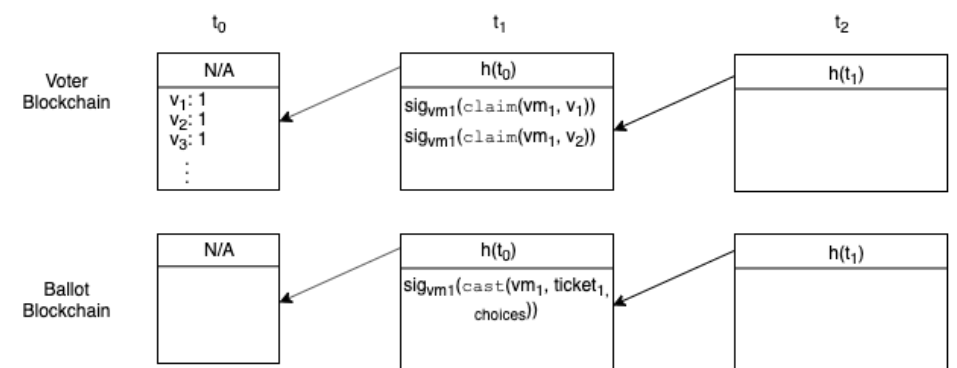
Fig. 2. Proposed architecture